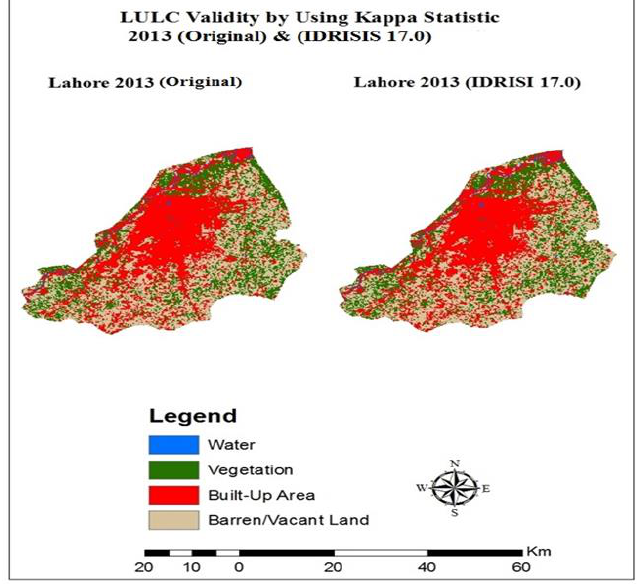
Figure 4: Validity of LULC by using Kappa Statistic Table 7: Predicted LULC cover of 2023 and 2028 for Lahore Study